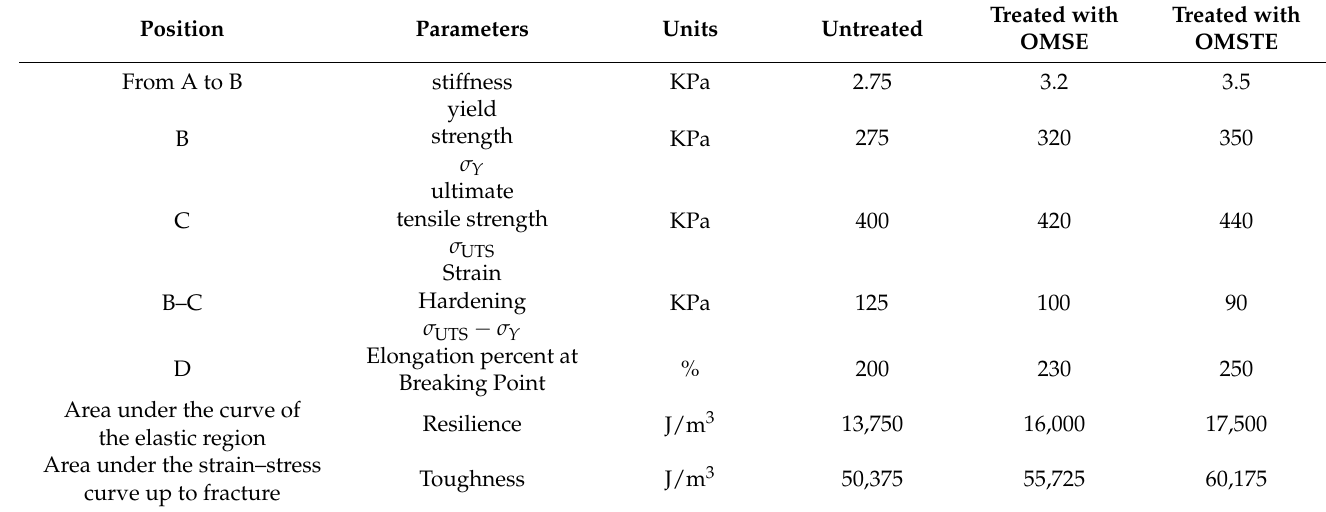
Table 1. The mechanical characteristics of the pre-treated and treated Ihram cotton fabric